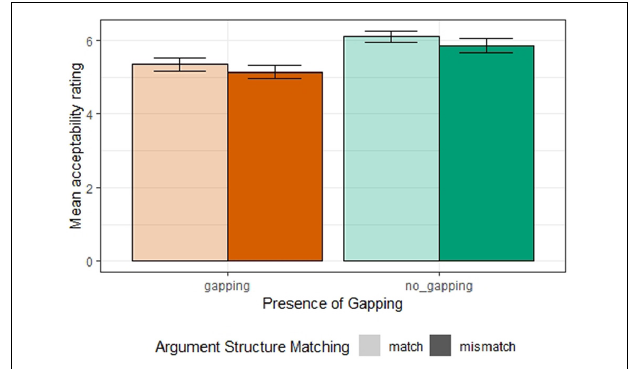
FIGURE 4 | Mean acceptability ratings for all conditions (Experiment